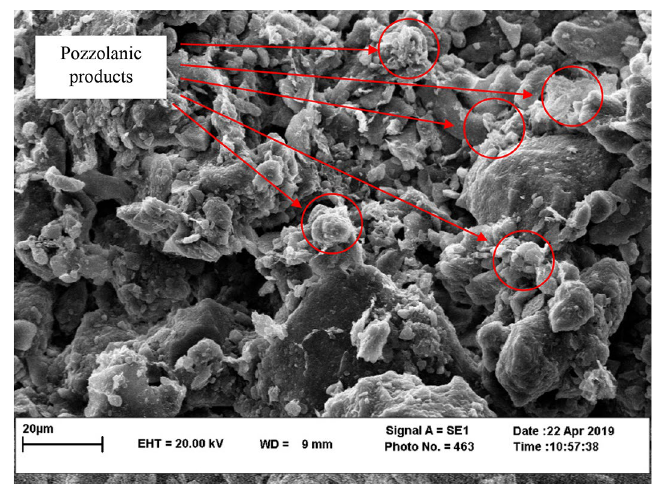
Figure 7. SEM micrograph of the VA 10 D 90 -S treated soil.